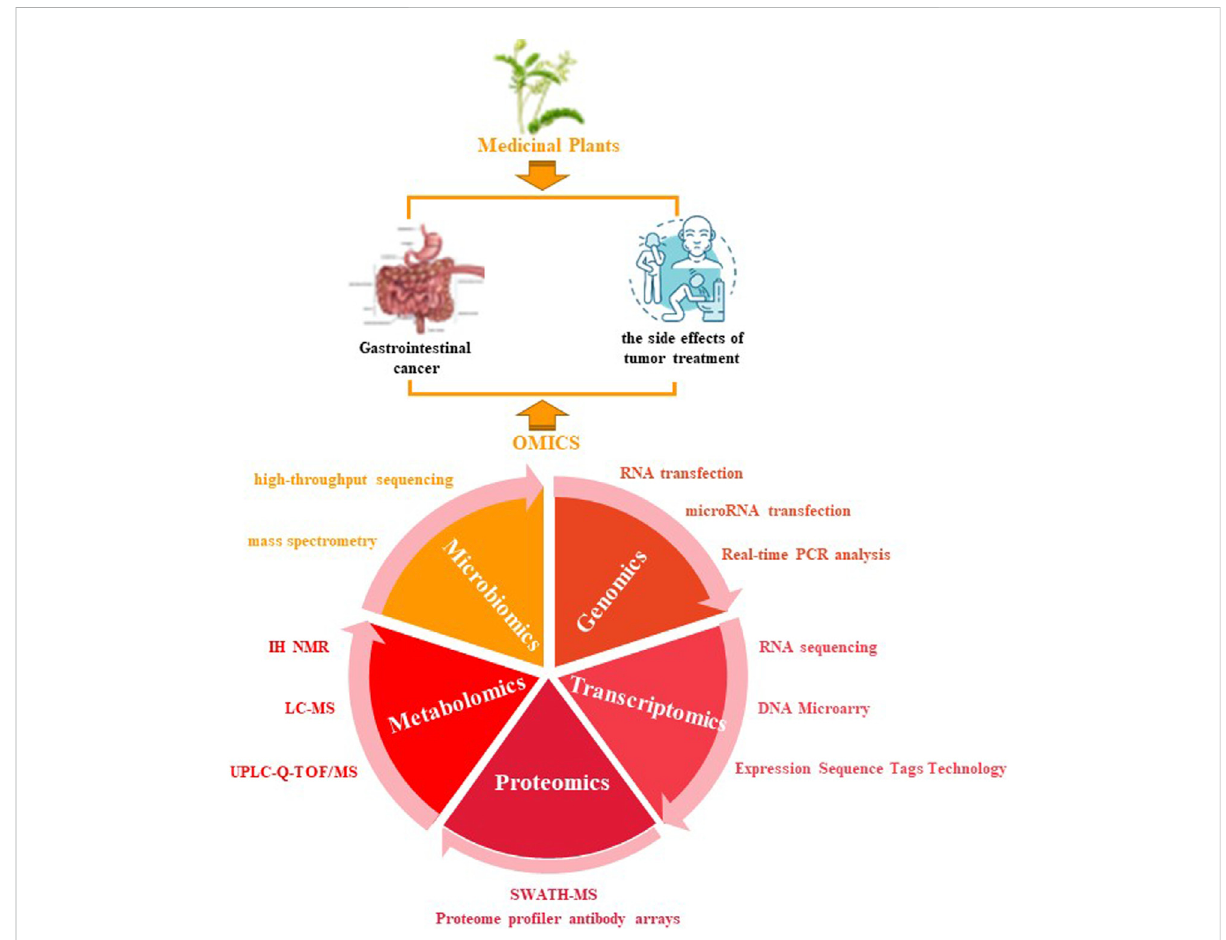
FIGURE 1 Application of omics assays in studying Chinese herbal medicines for treating gastrointestinal cancer. Application of omics approaches in GI cancer treatment with Chinese herbal medicines.